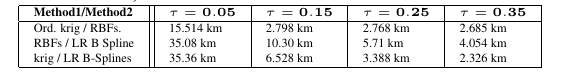
Table 7: Averaged geographical (measured in km) and rainfall distance (measured in mm) between sets of local maxima. Krig/(Radar+Krig) τ = 0 . 05 τ = 0 . 15 τ = 0 .